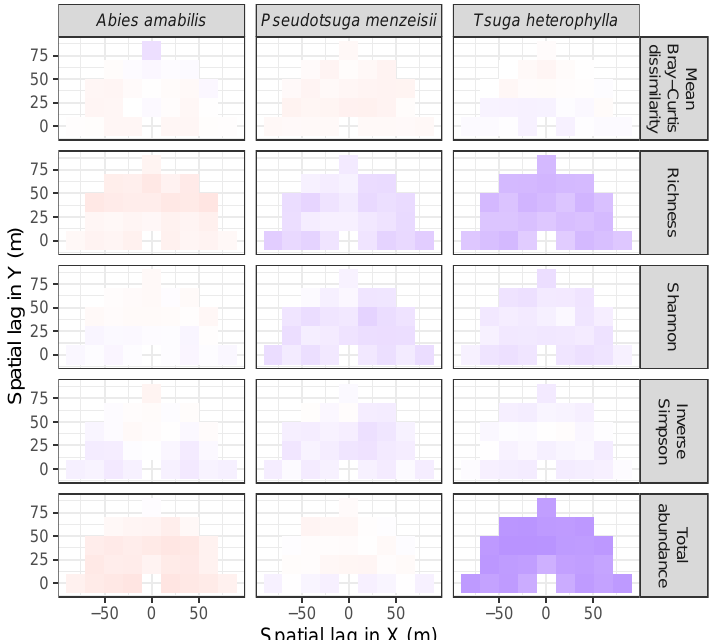
Figure 11. Codispersion between measures of diversity and total basal area of the three focal tree species in 20 20-m subplots in the 25.6-ha Wind River plot. Codispersion coefficients were calculated for spatial lags ranging from 0–105 m at 20-m intervals. The value of the codispersion coefficient can range from 1 (dark blue) through 0 (white) to 1 (dark red). Statistical significance of each codispersion coefficient is shown in Figures 12 and A1. Summaries of codispersion values are given in Table A1).